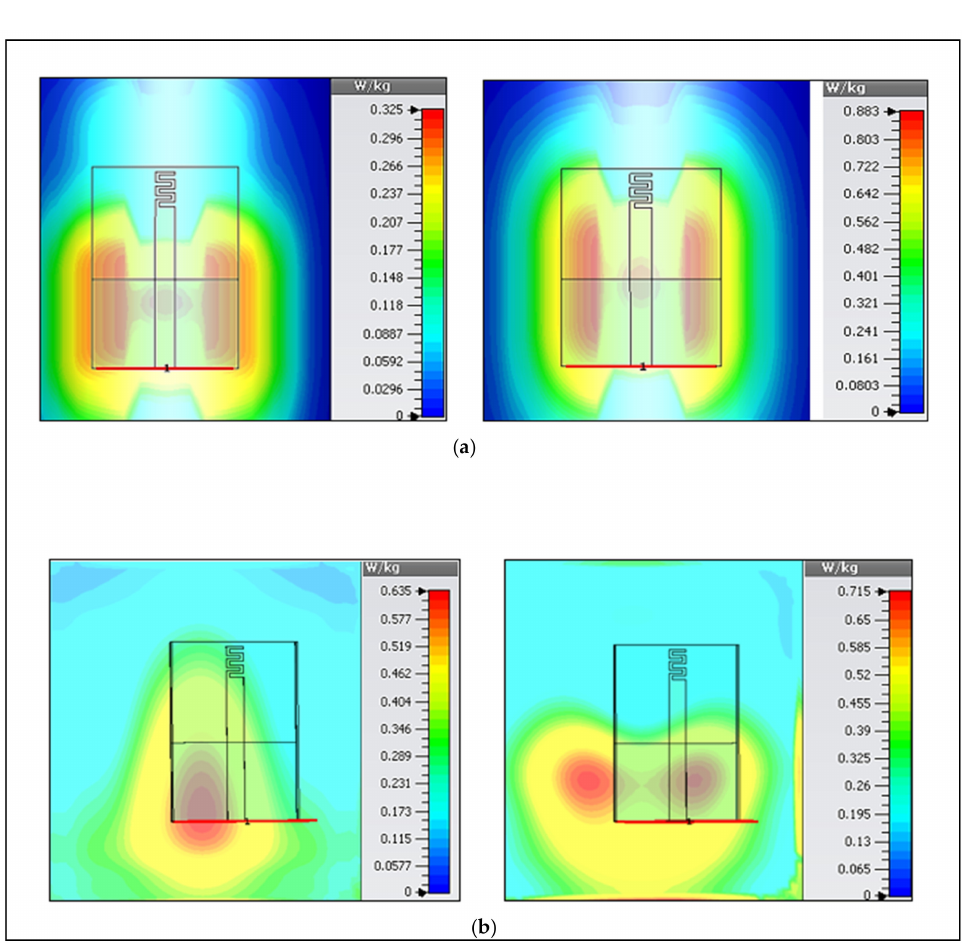
Figure 11. Simulated SAR (10-g average) results when the antenna is on the ( a ) upper-right arm of a male subject (at 2.2 GHz (left) and 5.7 GHz (right)), and ( b ) on the chest center (2.3 GHz (left) and 5.7 GHz